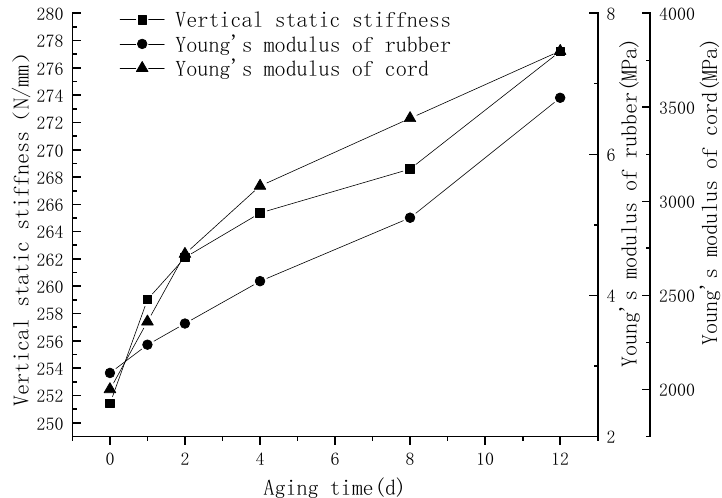
Figure 3. Aging test results.